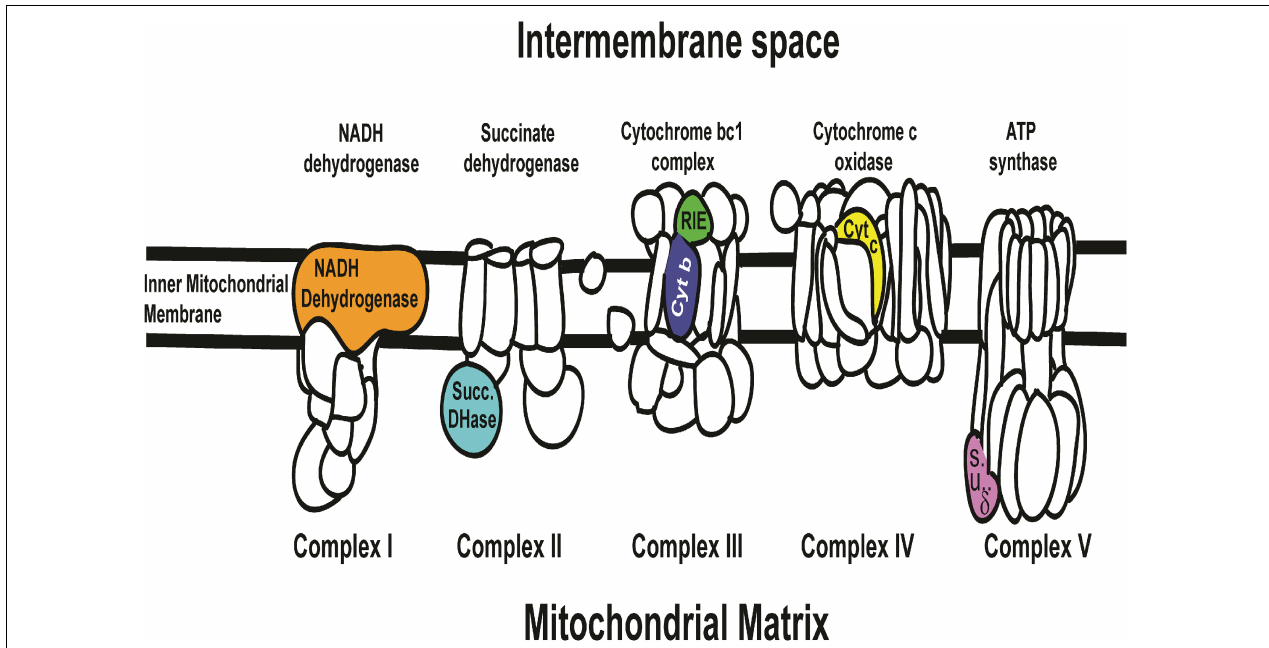
FIGURE 5 | Six ETC (Electron Transport Chain complexes) genes that were screened in artificial diet bioassay ( Figure 1A ) in relation to the KEGG map cartoon of the oxidative phosphorylation chain in complexes I, II, III, IV, and V (NADH dehydrogenase membrane domain, Succinate dehydrogenase flavoprotein, Cytochrome bc1 complex ISP and Cytb, Cytochrome c oxidase VIa and ATP synthase δ subunit, respectively) and their relative position in relation to the intermembrane space, inter mitochondrial membrane and matrix is shown. Diets targeting Rieske (green color) and Succinate Dehydrogenase (blue color) transcripts resulted in significant mortality (see Figure 1 ). Cognate proteins of these two gene correspond to soluble domains of the ETC. None of the membranous domains targeted showed significant mortality (see Figure 1 ). Succinate Dehydrogenase (blue color) is oriented toward the mitochondrial matrix while Rieske (green color) is oriented toward the intermembrane space with greater access to the cytosolic environment. The ETC cartoon is based on available models of NADH dehydrogenase ( Thermus thermophilus ), Succinate dehydrogenase ( E. coli ), Cytochrome bc1 complex (bovine), Cytochrome c oxidase (bovine), and ATP synthase ( E. coli ).